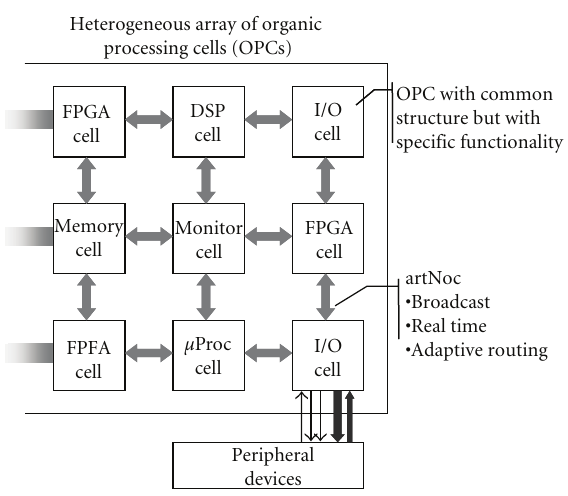
Figure 1: DodOrg organic hardware architecture